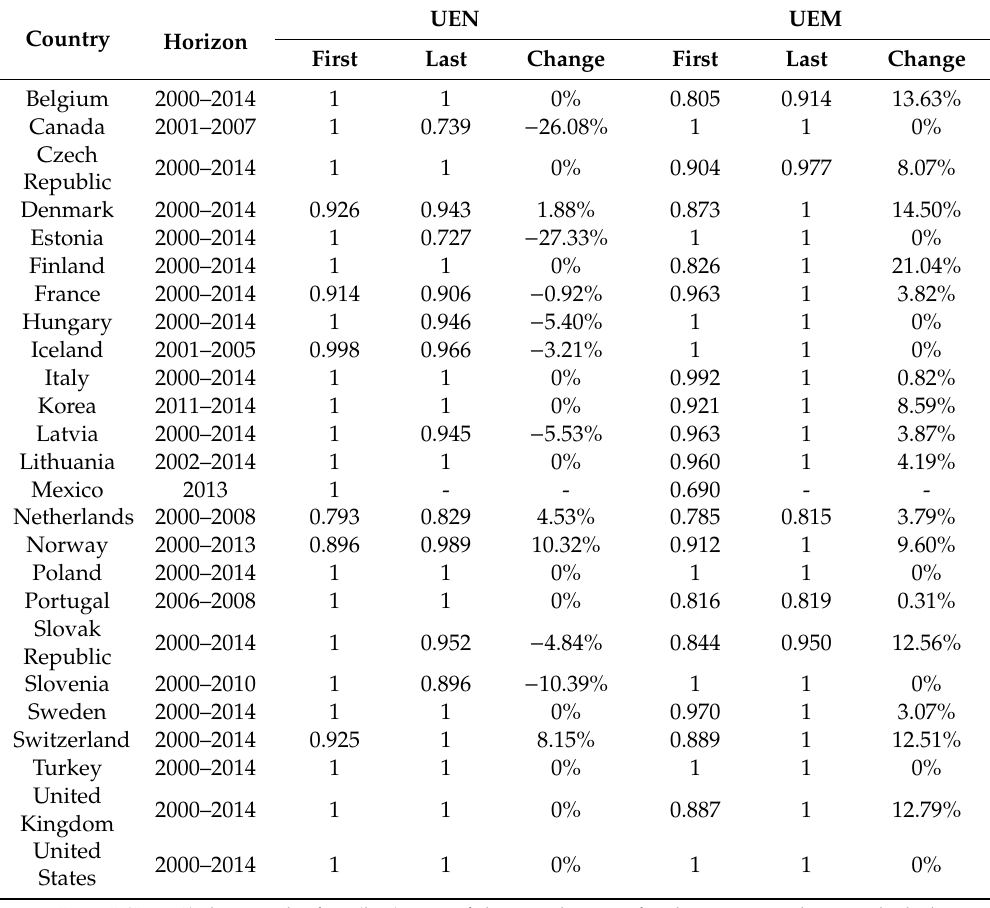
Table 2. UEN and UEM for all